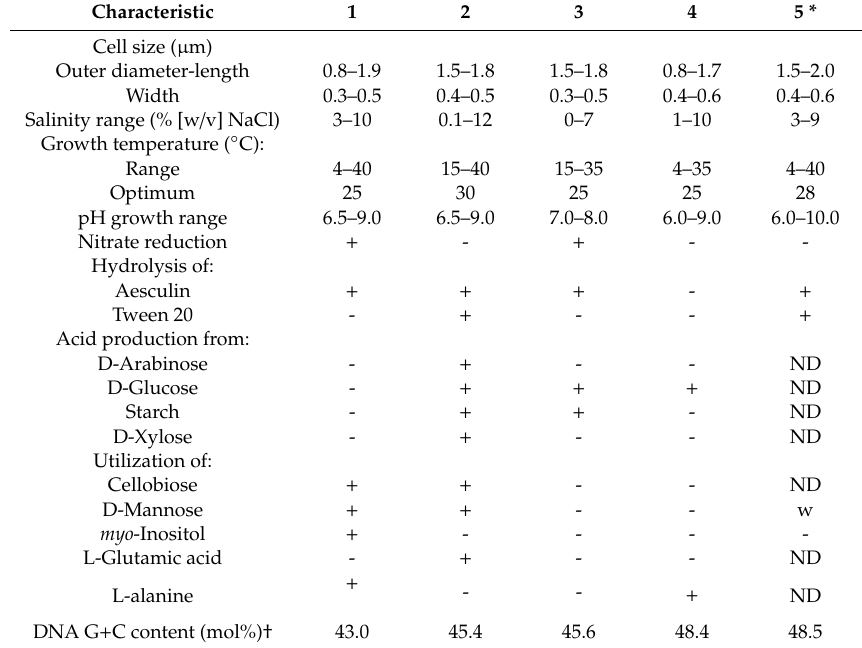
Table 4. Di ff erential characteristics between strain GBPx2 T and phylogenetically related species of the genus Cyclobacterium. Strains: 1, strain GBPx2 T ; 2, Cyclobacterium lianum IBRC-M 10422 T ; 3, Cyclobacterium jeungdonense IBRC-M 11102 T ; 4, Cyclobacterium halophilum IBRC-M 10761 T ; 5, Cyclobacterium xiamenense CGMCC 1.12432 T